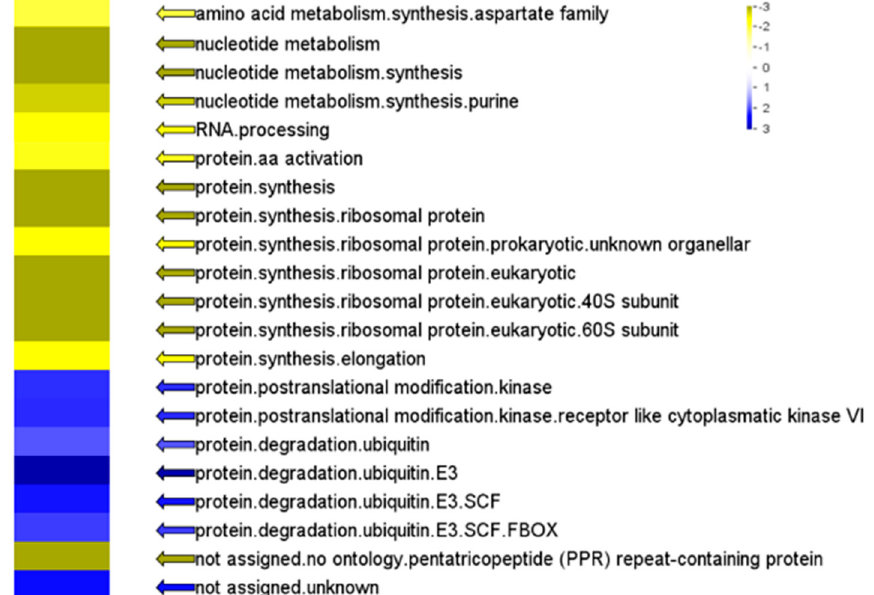
Figure 6. Over-represented analysis (ORA) of genes of the variegated milky stripe fig leaf. Functional gene categories (and sub-categories) of green and white sectors were determined by PageMan. Blue and yellow represent up- and down-regulated genes which are significantly overrepresented, respectively. Values were false color coded using a scale of − 3 to +3.